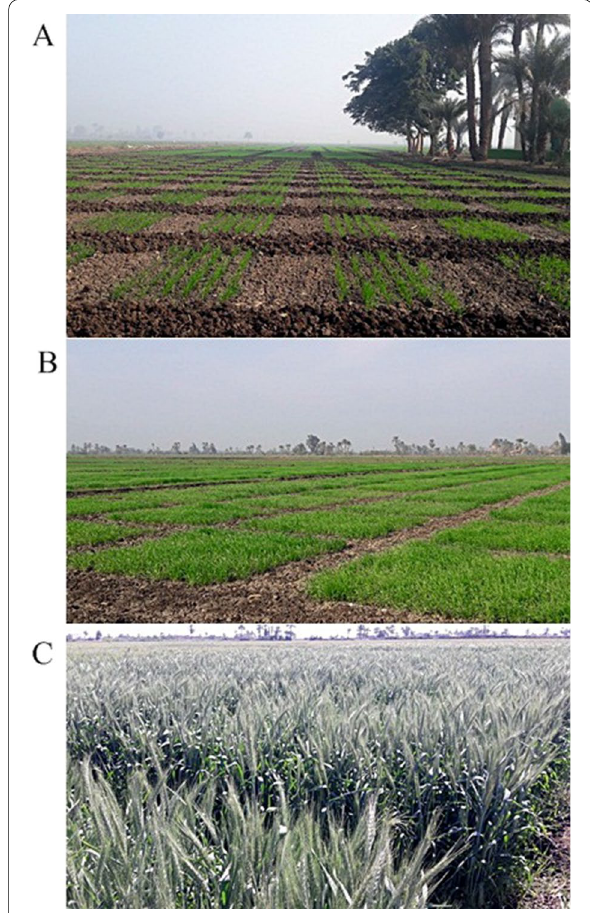
Fig. 1 Randomized complete blocks design of the field experiments on integrated biofertilization effects on growth and productivity of wheat plant A : after 3 weeks of germination, B : tillering stage and C: heading and flowering